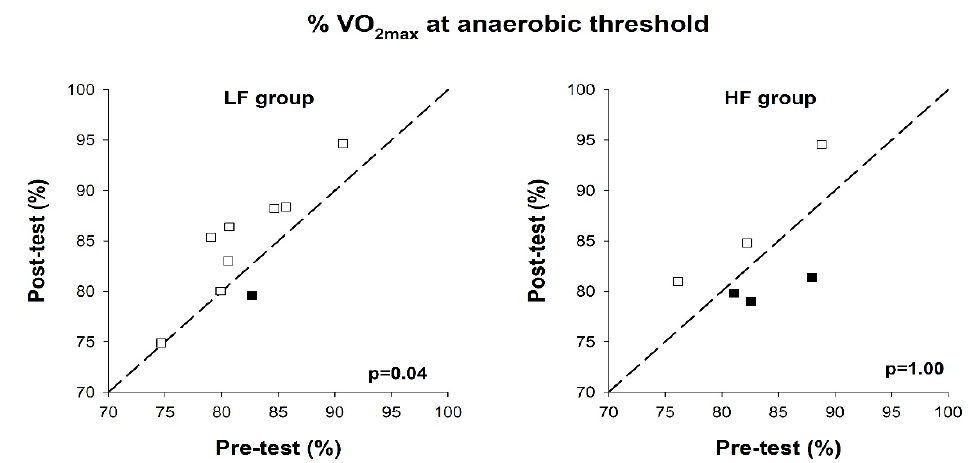
Figure 4. % of VO 2max at anaerobic threshold at pre-test and post-test, in the low-frequency group (LF group) and high-frequency group (HF group). Reference lines indicate identical values at pre- and post-test. Each box represents a test subject. Open boxes indicate an improvement and filled boxes indicate a decline, compared to the pre-test.